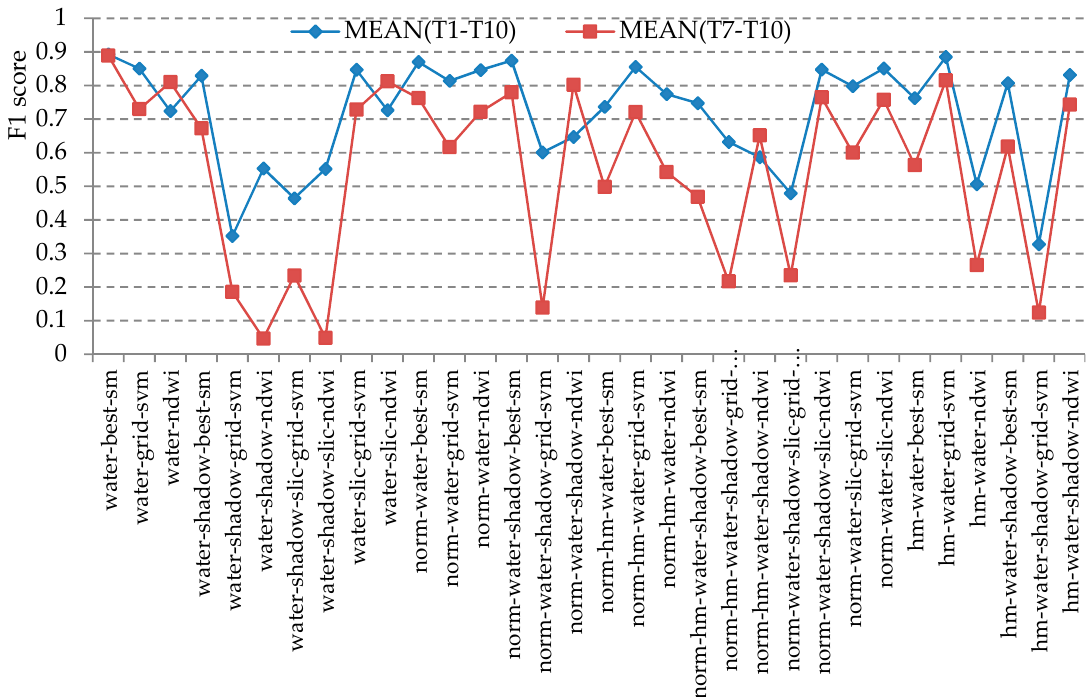
Figure 6. Illustration of the mean and variance of the F1 scores on all 10 test data based on the 32 combinations from the three classic methods, as indicated in Table 4.